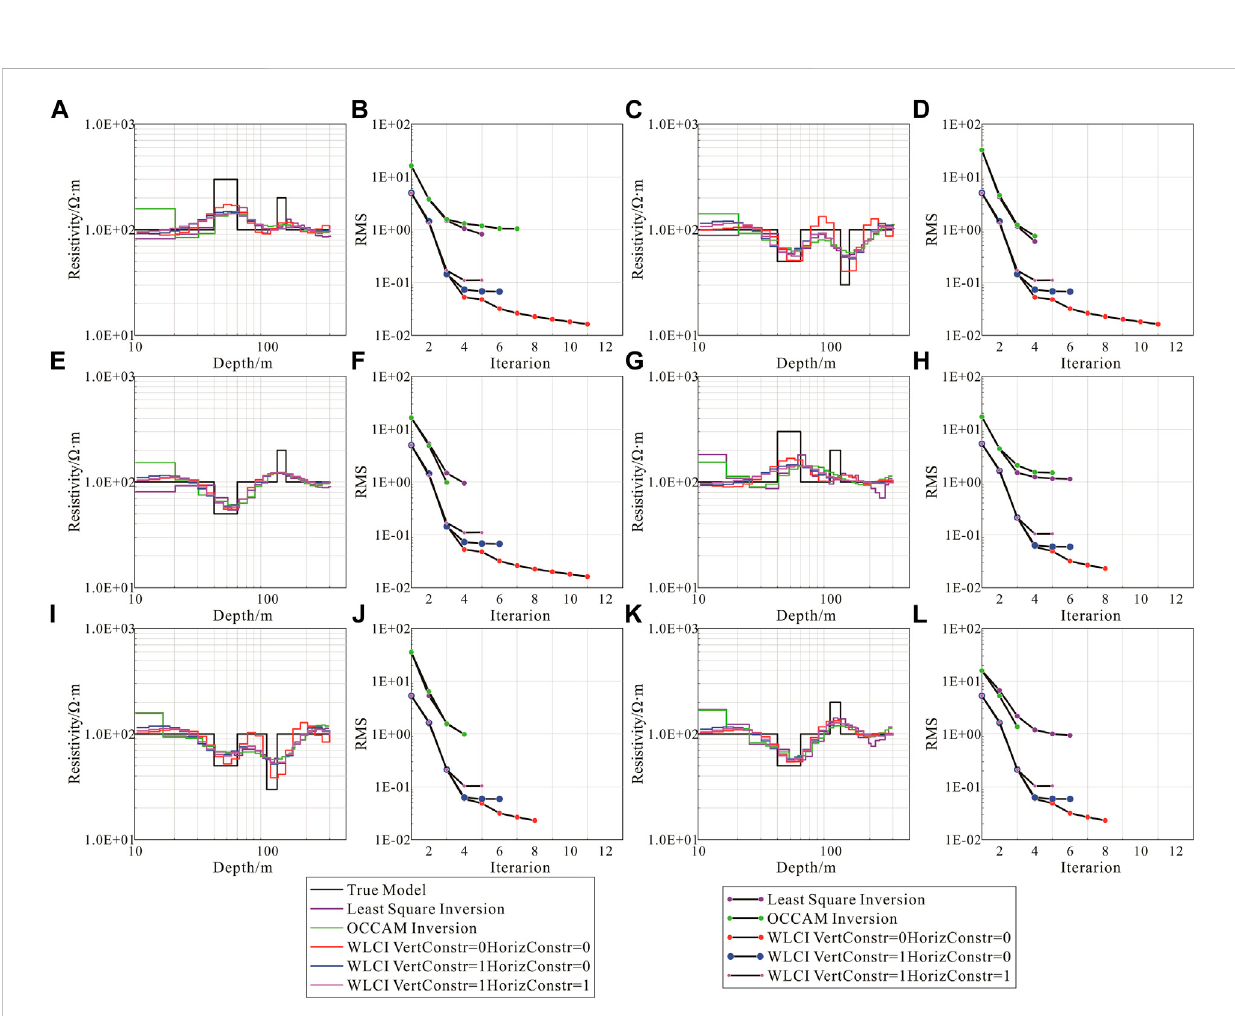
FIGURE 7 Single-point inversion results for different points. (A) : Single-point inversion results at X = 40 m of model 1. (B) : The Root Mean Square (RMS) at X = 40 mofModel1. (C) :Single-pointinversionresultsat X =100 mofmodel1. (D) :TheRMSat X =100 mofmodel1. (E) :Single-pointinversionresultsat X = 360 m of model 1. (F) : The RMS at X = 360 m of model 1. (G) : Single-point inversion results at X = 40 m of model 2. (H) : The RMS at X = 40 m of model 2. (I) : Single-point inversion results at X = 100 m of model 2. (J) : The RMS at X = 100 m of model 2. (K) : Single-point inversion results at X = 360 m of model 2. (L) : The RMS at X = 360 m of model